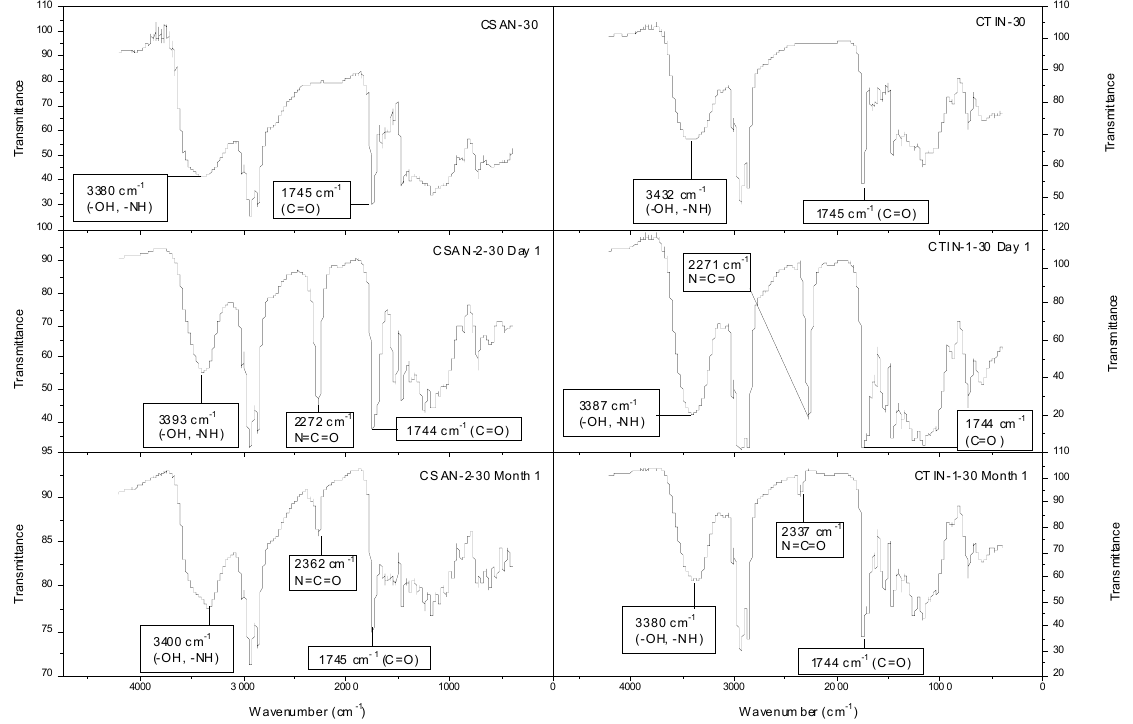
Figure 7. FTIR spectra for selected –NCO-functionalized and non-functionalized chitosan and chitin gel-like dispersions in castor